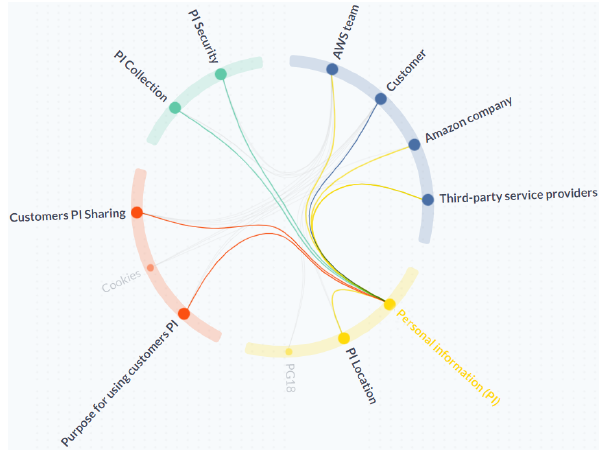
Figure 5. AWS Infolet circle related to the keyword “Personal information”.